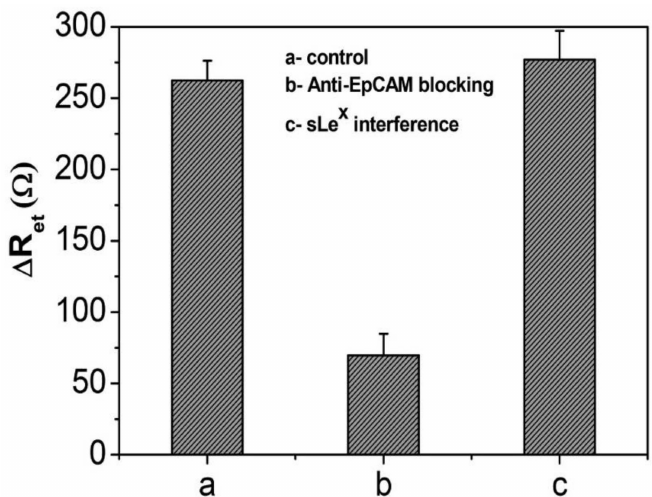
Figure 4. Specificity and interference investigation. Sample a is the cell suspension without any special treatments; Sample b is the cell suspension that is blocked by Anti-EpCAM. Sample c is the cell suspension added to with sLe X . Cell concentration: 1.0 × 10 6 cells mL − 1